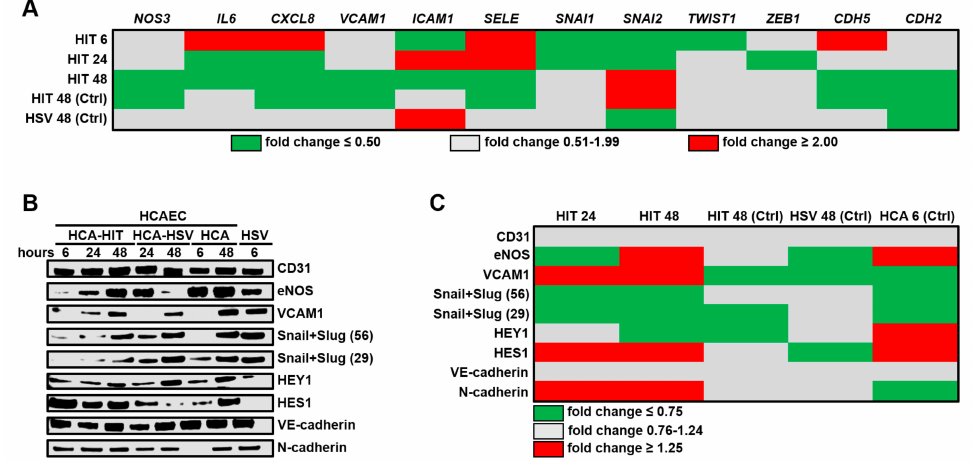
Figure 1. Profiling of key endothelial molecules in human coronary artery endothelial cells (HCAECs) co-cultured with either human internal thoracic artery endothelial cells (HITAECs) (HIT) or human saphenous vein endothelial cells (HSaVECs) (HSVs) for 6, 24, or 48 h. ( A ) RT-qPCR profiling, HIT signifies the ratio of transcript levels (measured as ∆ Ct) in HCAECs co-cultured with HITAECs to those in HCAECs co-cultured with HSaVECs. HIT (Ctrl) and HSV (Ctrl) represent the ratios of transcript levels (measured as ∆ Ct) in HCAECs co-cultured with HITAECs or HSaVECs to those in HCAEC monoculture. Results are represented as the heat map; green, gray, and red colours indicate fold change ≤ 0.50, 0.51–1.99, and ≥ 2.00, respectively; ( B ) Western blotting measurements. HCA-HIT represents HCAECs co-cultured with HITAECs, HCA-HSV signifies HCAECs co-cultured with HSaVECs. HCA and HSV signify HCAEC and HSaVEC monocultures, respectively; ( C ) Semi-quantitative analysis of Western blotting results by densitometry. HIT represents the ratio of band density in HCAECs co-cultured with HITAECs to that in HCAECs co-cultured with HSaVECs. HIT (Ctrl) and HSV (Ctrl) abbreviate the ratios of band density in HCAECs co-cultured with HITAECs or HSaVECs to that in HCAEC monoculture. HCA (Ctrl) abbreviates the ratio of band density in HCAEC monoculture to that in HSaVEC monoculture. Snail + Slug are shown at both 56 and 29 kDa values. Results are represented as green, gray, and red colours on the the heat map, indicating fold changes of ≤ 0.75, 0.76–1.24, and ≥ 1.25,